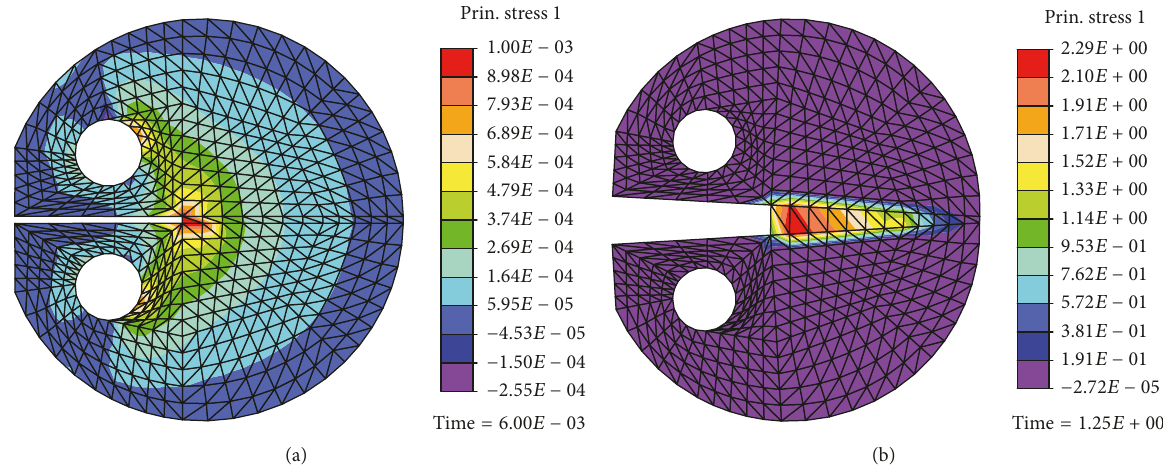
Figure 10: Principal stress 𝜎 𝐼 , (a) at the initiation damage, and (b) at a total damage state.